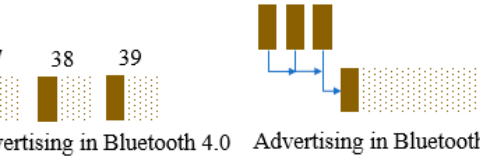
Figure 4. Difference in advertisement mode between classic and extended versions.